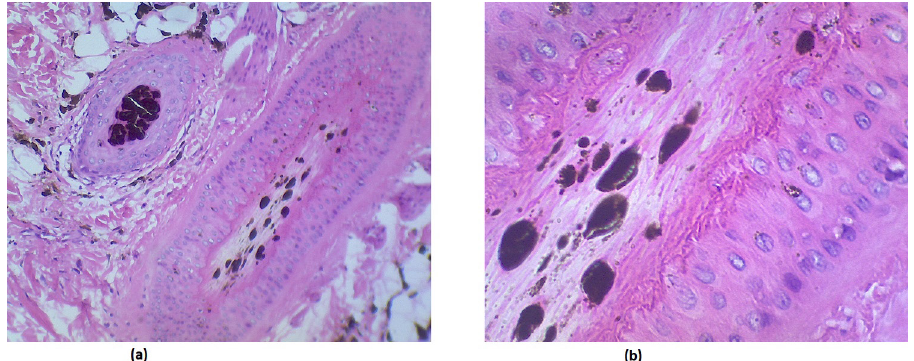
Figura 3. Exame histopatológico de cão SRD diagnosticado com Alopecia por Diluição da cor demonstrando agregados de melanina no folículo